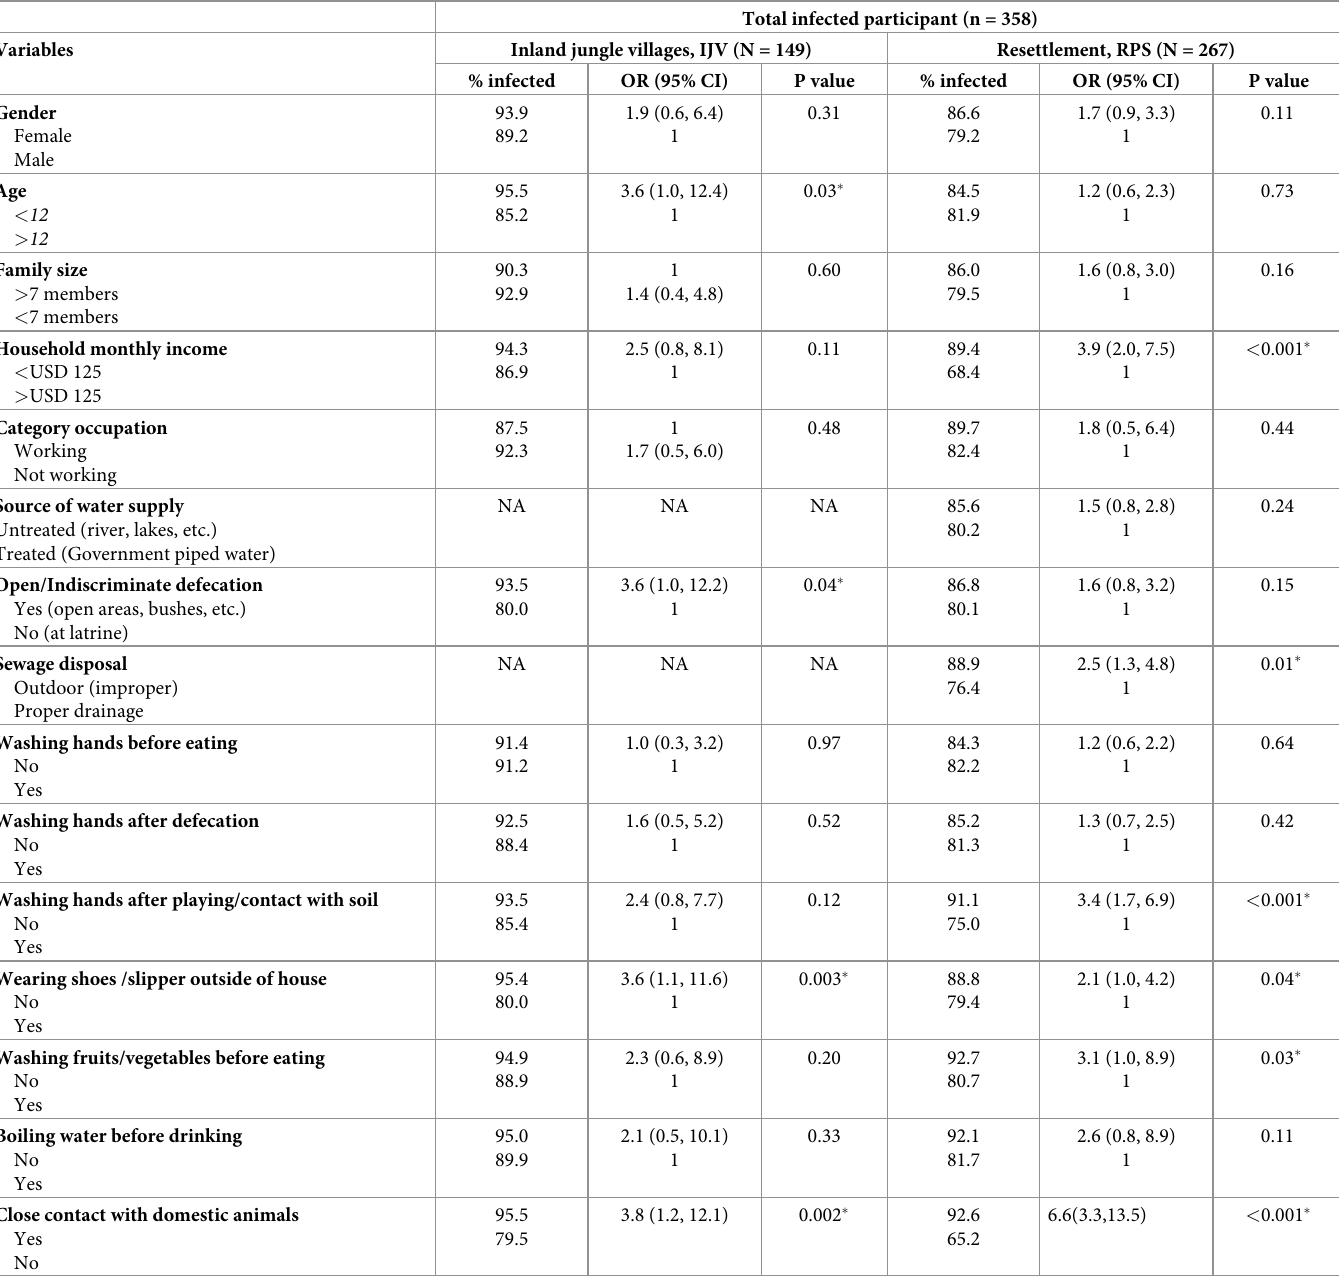
Table 5. Potential risk factors associated with STH infections among IJV and RPS communities (logistic regression univariate analysis). Total infected participant (n = 358) Inland jungle villages, IJV (N =